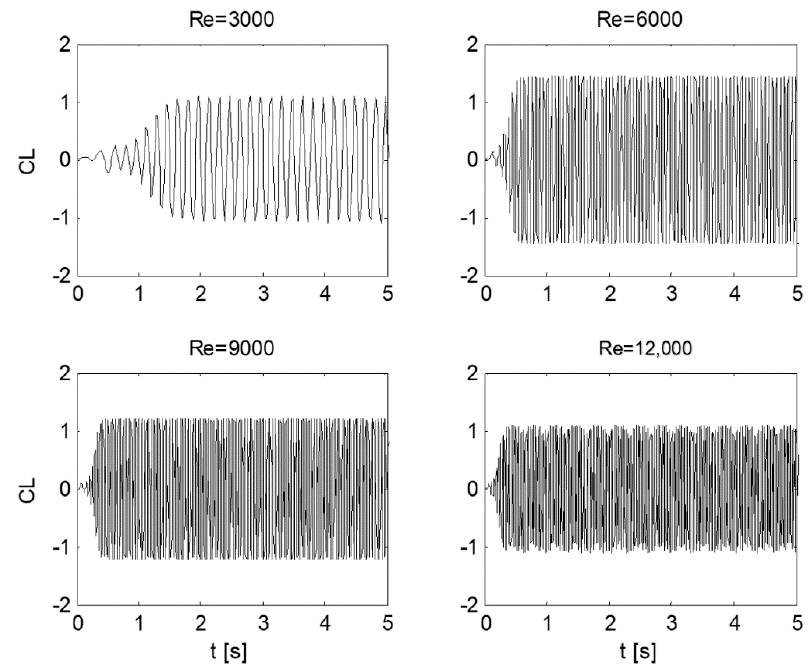
Figure 6. Lift coefficient evolution for different Reynolds numbers.